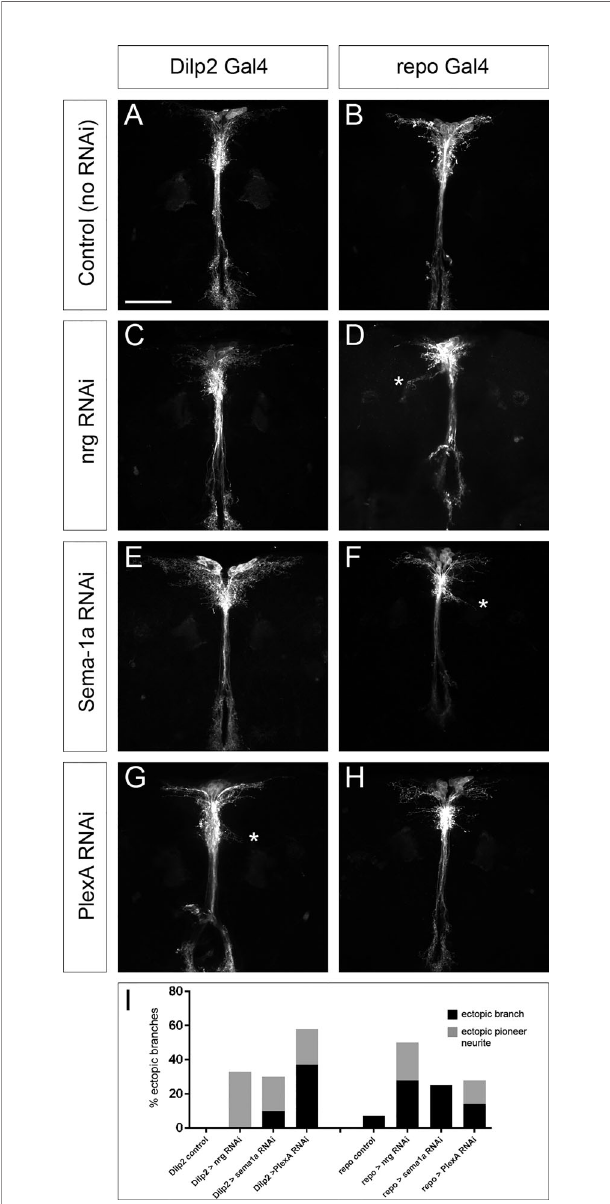
FIGURE 5 | Cell- and non-cell autonomous contributions of nrg , Sema-1a , and PlexA to the IPC neuronal differentiation phenotype. Cell-type speci fi c RNAi knockdowns were performed and compared to (A, B) control brains with the Gal4 driver alone. (C) Brains in which nrg was knocked down in the IPCs do not exhibit any major phenotypes, while (D) nrg knockdown in glia results in ectopic branching as well as a reduction in lateral neurite complexity. (E) IPC knockdown of Sema-1a results primarily in an increase in lateral neurite complexity, but also occasionally in mild ectopic branch phenotypes (not shown; see Table 2 ). (F) Sema-1a knockdown in glial cells results in more robust ectopic branches. (G) Knockdown of the Sema-1a receptor PlexA in IPC neurons gives rise to ectopic branches with high penetrance, while (H) knockdown of PlexA in glia results in ectopic branches much less frequently. (I) Graph showing the frequency of ectopic branching phenotypes (both ‘ mature ’ ectopic branches as well as immature single- neurite pioneers) in the different RNAi knockdown conditions. Ectopic branches in (D, F, G) are marked with an asterisk. Scale bar = 50 m